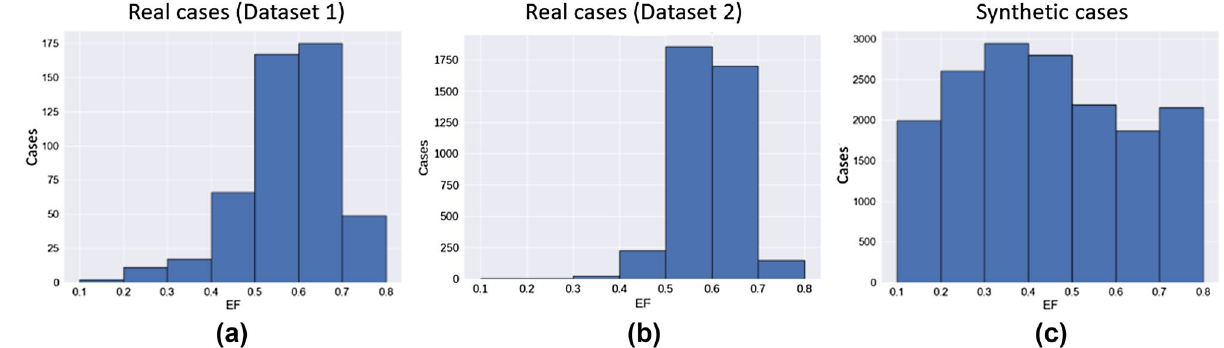
Figure 1. Normal EF distributions of the 491 real cases from the Dataset 1 ( a ) and 3975 cases from Dataset 2 ( b ), and our 22,861 synthetically generated cases with a uniform EF distribution ( c